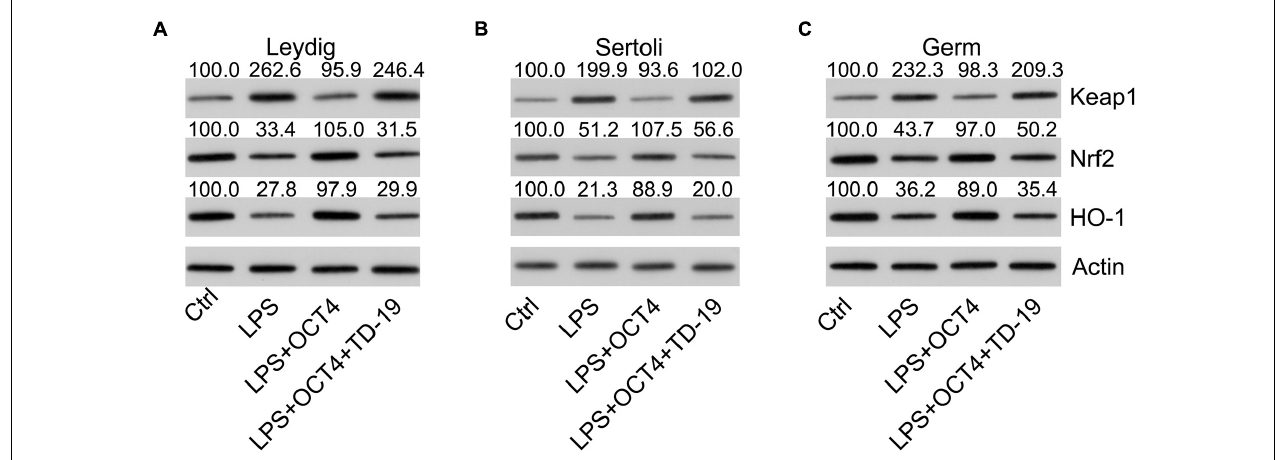
FIGURE 9 | Effects of OCT4 and CIP2A on the activation of the Keap1-Nrf2-HO-1 pathway in LPS-induced Sertoli, Leydig, and germ cells. Leydig, Sertoli, and germ cells were transfected with pcDNA3-OCT4 or pcDNA3-NC and then incubated with LPS and TD-19 for 12 h. (A–C) The levels of Keap1, Nrf2, and HO-1 in the cells were determined by